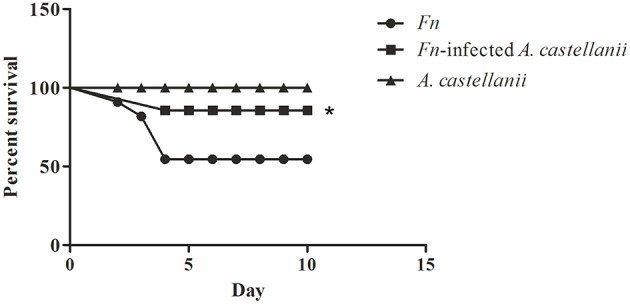
Survival of Balb/c mice. Balb/c mice inoculated intratracheally with F. novicida, A. castellanii, and/or F. novicida-infected A. castellanii were observed twice daily for 15 days for clinical signs of illness or survival. Results represent combined results of two separate experiments and 10 animals per treatment group, *p < 0.05.